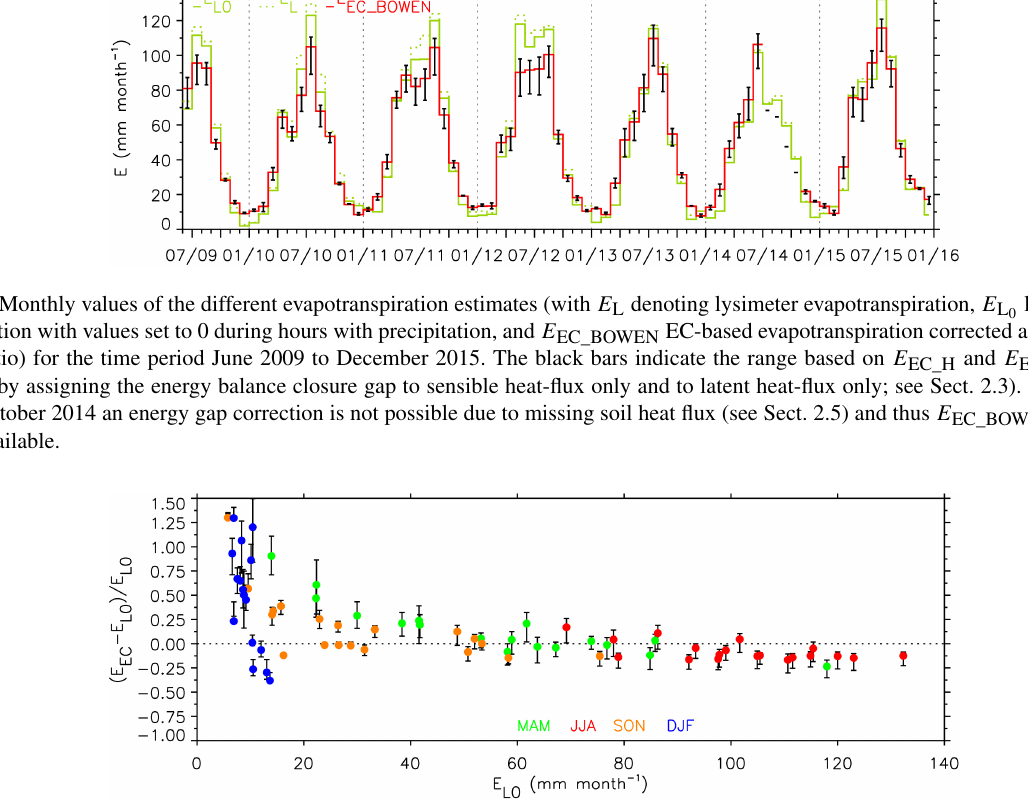
Figure 6. Monthly relative differences between lysimeter evapotranspiration E L and EC-based evapotranspiration E EC , i.e., 0 )/E L ( E EC − E L vs. the absolute values of E L . Different seasons are displayed in different colors. The points indicate E EC_BOWEN 0 0 0 ( E EC corrected according to the Bowen ratio) and the black bars indicate the range based on E EC_H and E EC_E ( E EC corrected by assigning the energy balance closure gap to sensible heat-flux only and to latent heat-flux only). Note that the July to October 2014 values with missing E EC_BOWEN and E EC_E (see Sect. 2.5) are